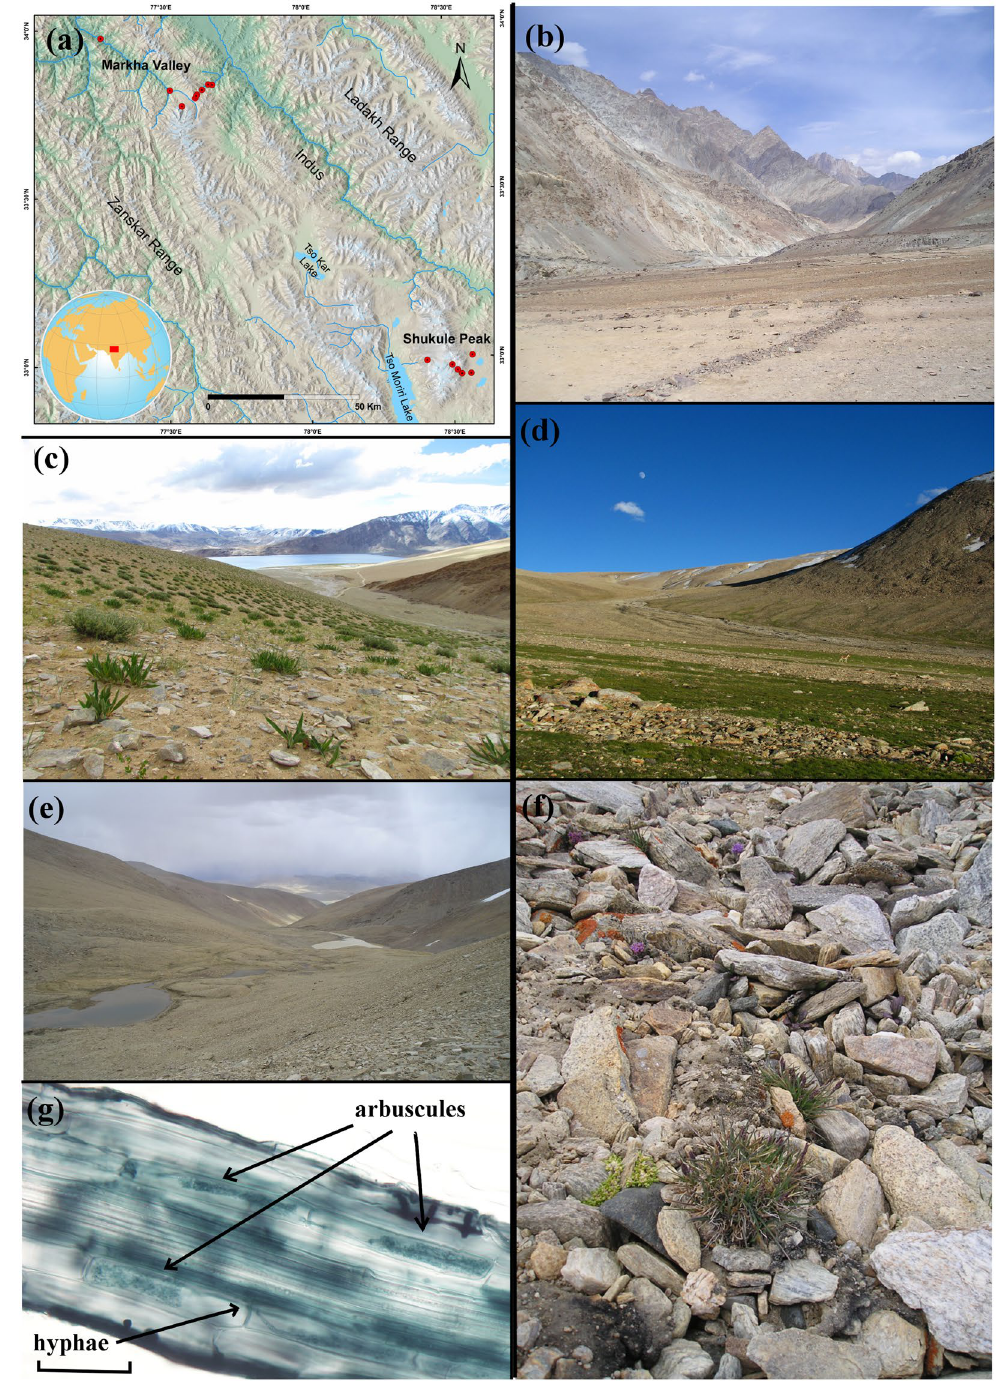
Figure 1. ( a ) Map of sampling sites (red point) in Ladakh, NW Himalaya. ( b ) Desert in lower part of Markha valley (3 400 m a.s.l.). ( c ) Steppe nearby the Tso Moriri Lake (4 800 m a.s.l.). ( d ) Alpine graslands nearby the Tso Moriri Lake (5 200 m a.s.l.). ( e ) Subnival vegetation on the eastern slope of the Shukule peak (5 800 m a.s.l.). ( f ) Habitat of Poa attenuata at 5800 m a.s.l. ( g ) Hyphae and arbuscules of AMF in a Poa attenuata root sample from 5800 m a.s.l. Map was generated in ArcGIS 10.2.1